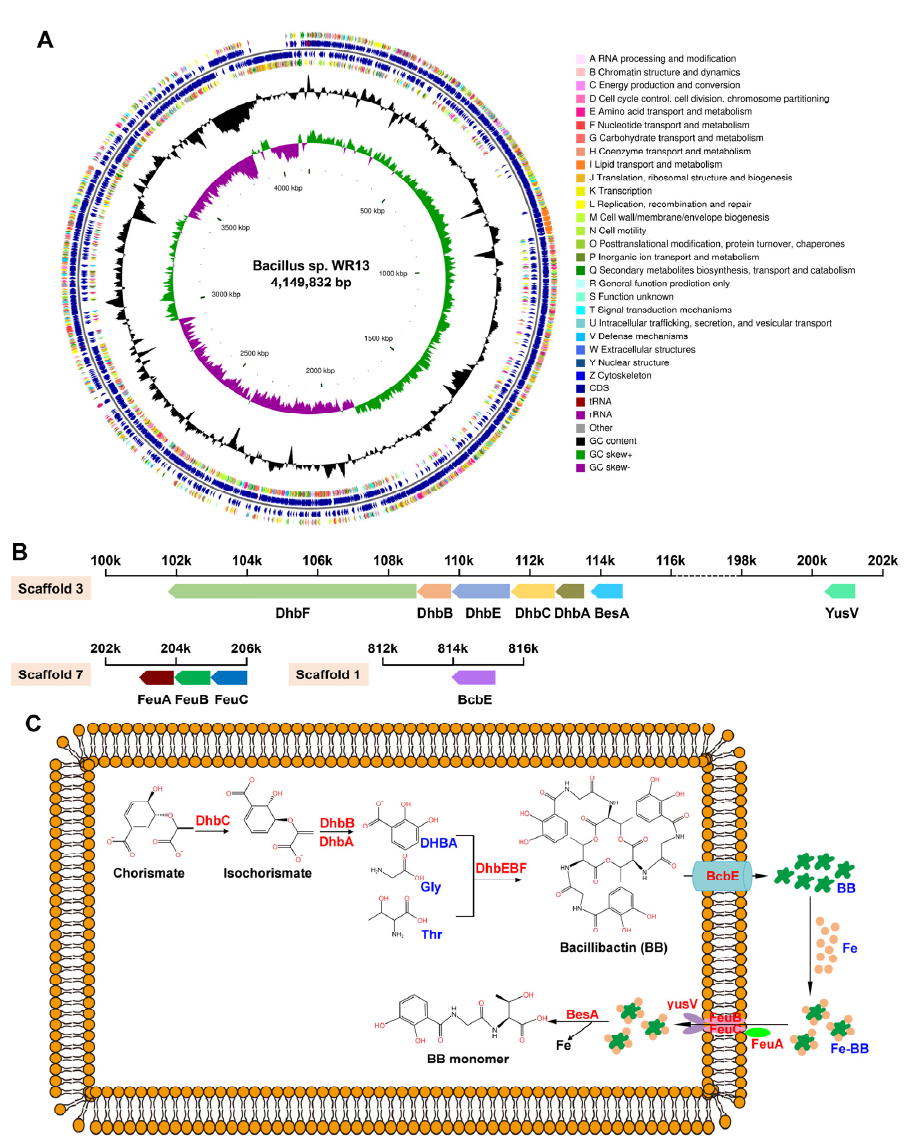
Figure 2. Genome information of Bacillus sp. WR13. ( A ) Circular genomic map of WR13. The circular map was generated using CGView software. Circles (from outside to inside) 1 and 4: CDSs on the forward and reverse strand; Circles 2 and 3: CDSs, tRNA, and rRNA on the forward and reverse strand; Circle 5: GC content; and Circles 6: GC skew. ( B ) Siderophore-related gene clusters in the chromosome. ( C ) The pathway of siderophore synthesis, transportation, uptake, and hydrolysis.